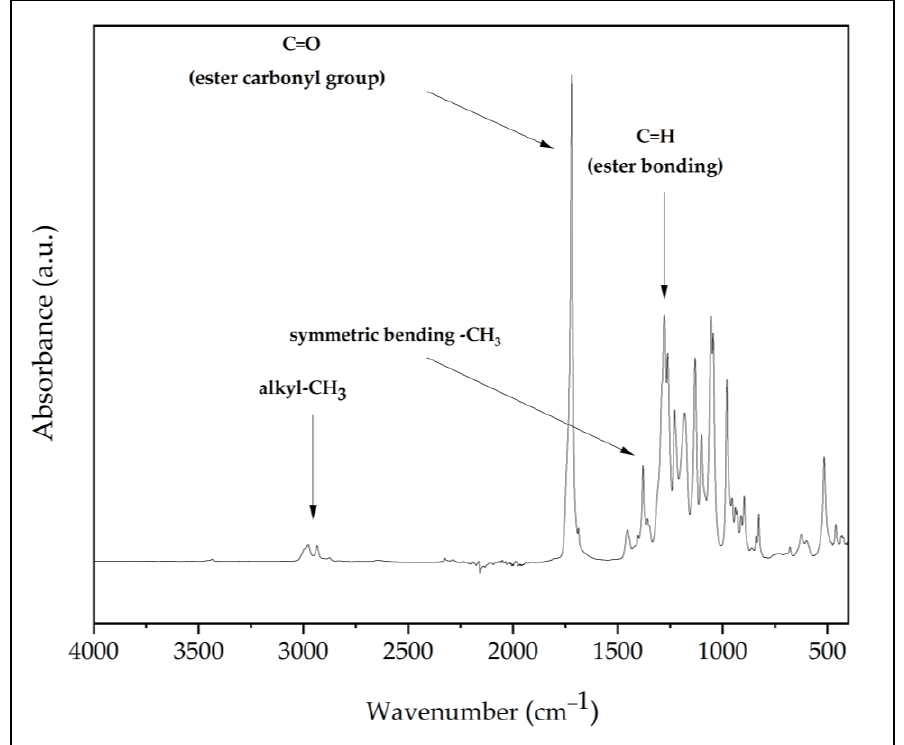
Figure 4. Infrared spectrum of PHB powder.